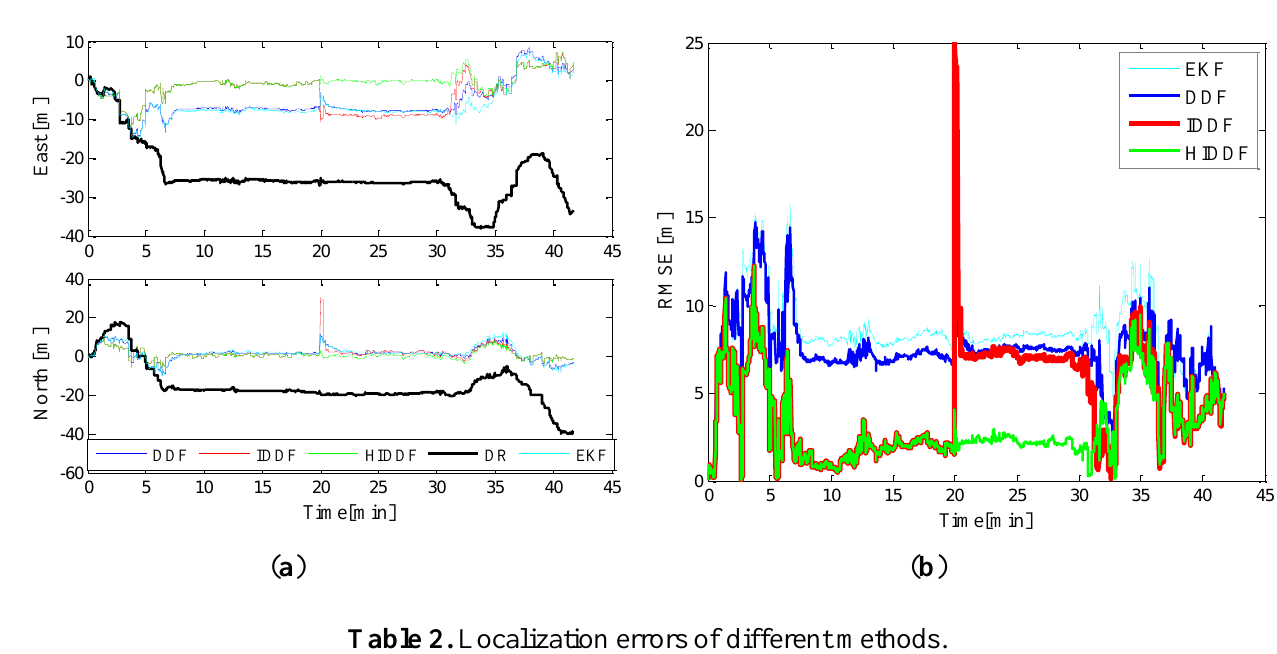
Figure 5. Simulation results in Experiment 1. ( a ) Position errors of different methods; ( b ) Position errors of EKF, DDF, IDDF and HIDDF.